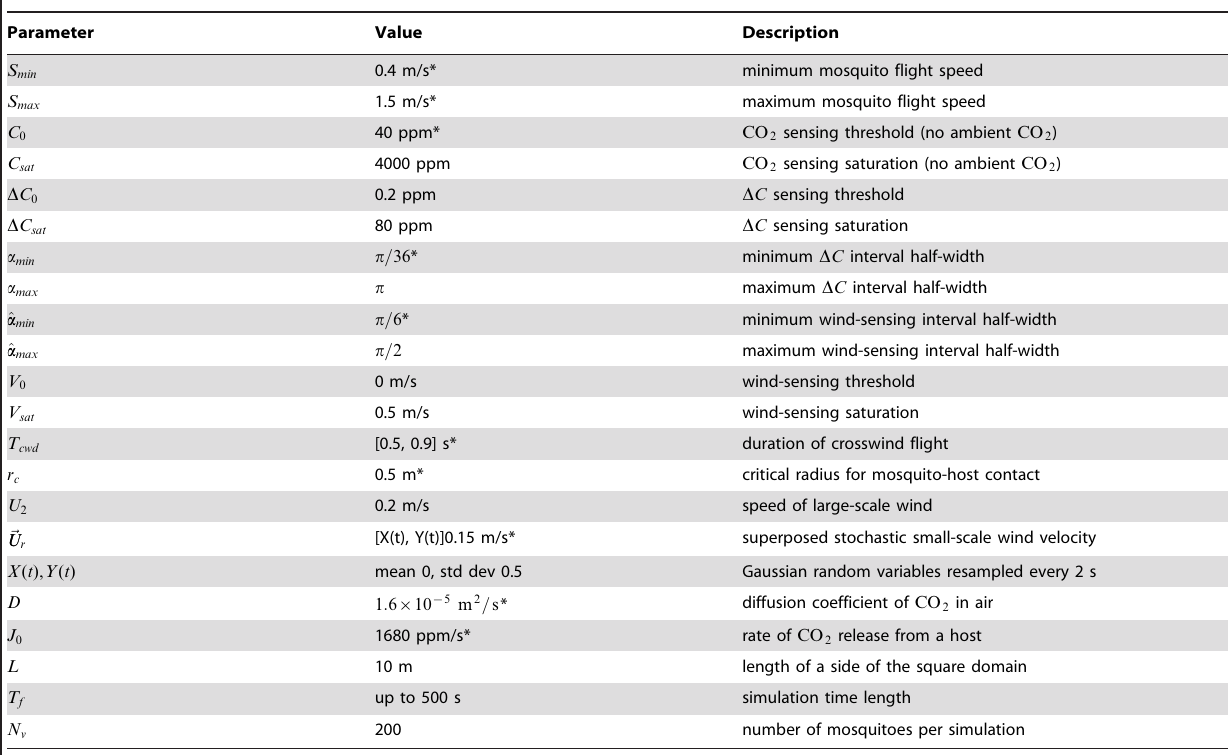
Table 1. Parameter